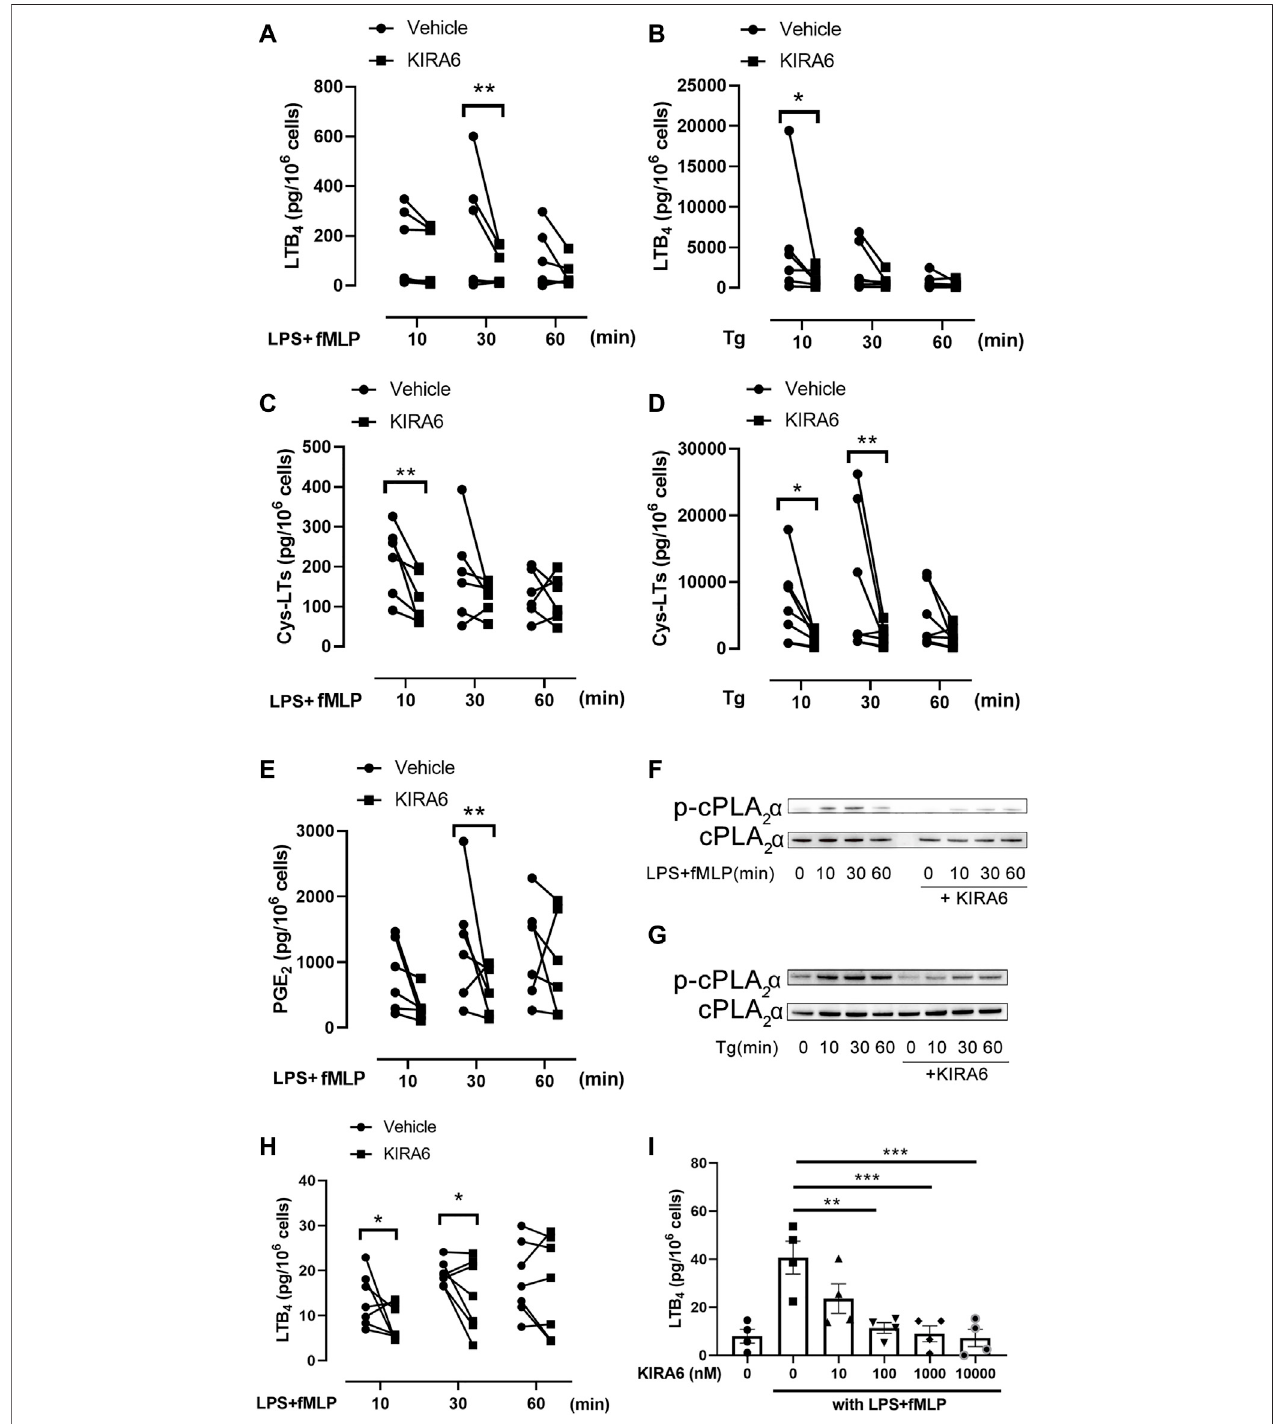
FIGURE 1 | KIRA6 inhibits leukotriene production from hMDMs and neutrophils. (A – E) hMDMs were pretreated with 1 µM KIRA6 or vehicle (0.1% DMSO) for 30 min. Afterwards, cells were treated with 100 ng/ml LPS for 10 min, followed by fMLP (1 µM) stimulation for 10, 30 or 60 min (A,C,E) , or stimulated with 1 µM thapsigargin(Tg)forthesametime (B,D) .LTB4,cys-LTsorPGE2inthecellsupernatantswereanalyzedbyELISA. (A) : n =5, (B – E) : n =6. (F,G) PhosphorylatedcPLA 2 α (p-cPLA 2 α )andcPLA 2 α proteinwereanalyzed bywesternblot(representative ofthreeindependentexperiments). (H,I) Neutrophilsweretreatedwithvehicle(0.1% DMSO)or1 µMKIRA6,followedbyLPS(100 ng/ml)andfMLP(1 μ M)stimulationfor10,30or60 min (H) ( n =7).Alternatively,neutrophilsweretreatedwithvehicle(0.1% DMSO) or different concentrations of KIRA6 for 30 min, followed by LPS (100 ng/ml, 10 min), and fMLP (1 μ M, 30 min) stinulation (I) ( n = 4). LTB 4 production in cell supernatants was analyzed by ELISA. *p < 0.05, **p < 0.01, ***p < 0.001, ****p < 0.0001.